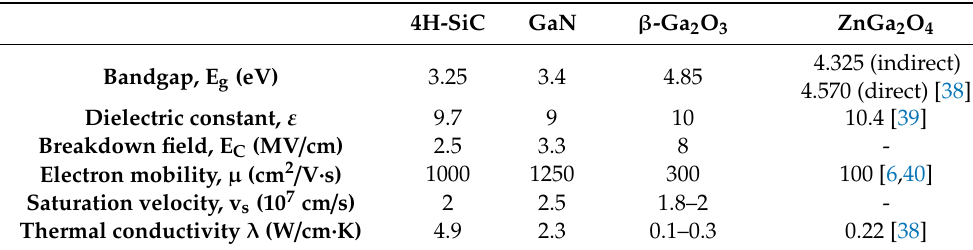
Table 1. Comparison of various wide-bandgap semiconductor materials properties (the data are from [37] except for ZnGa 2 O 4